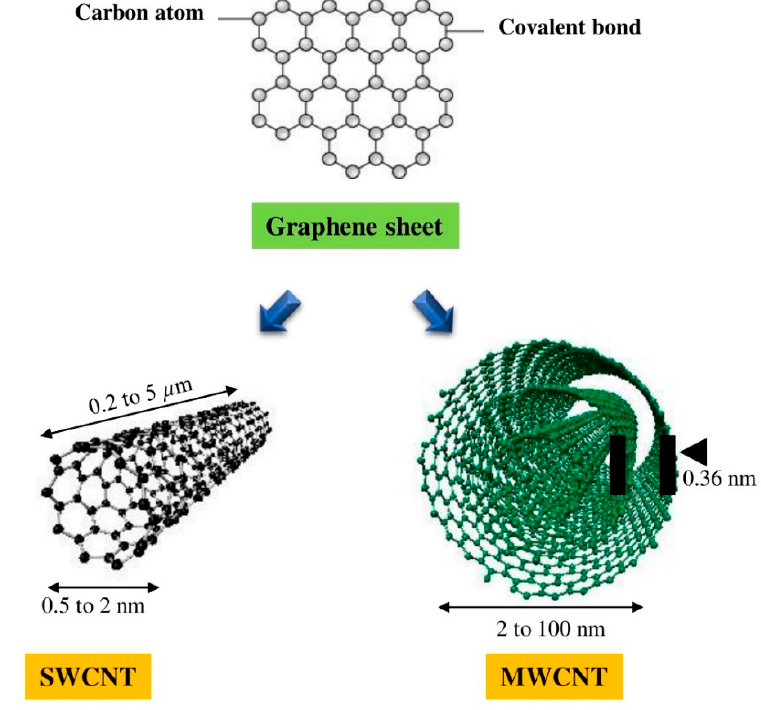
Figure 1. The conceptual diagram showing the general dimensions of the length and width of single-walled carbon nanotubes (SWCNTs) and multi-walled CNTs (MWCNTs) [2]. Table 1. Comparative study between single-walled carbon nanotubes (SWCNTs) and multi-walled carbon nanotubes (MWCNTs) [2].